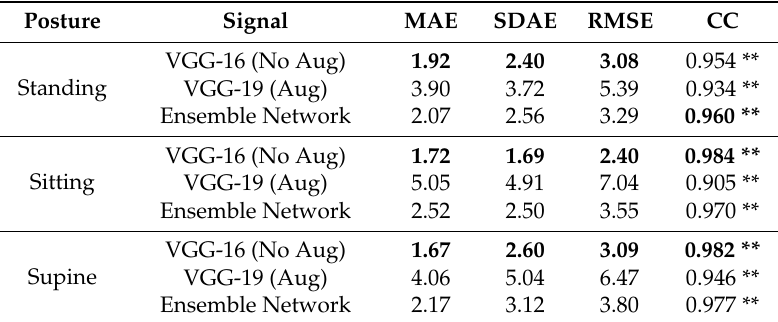
Table 2. Estimation of heart rate in relaxed condition by CNNs. Posture Signal